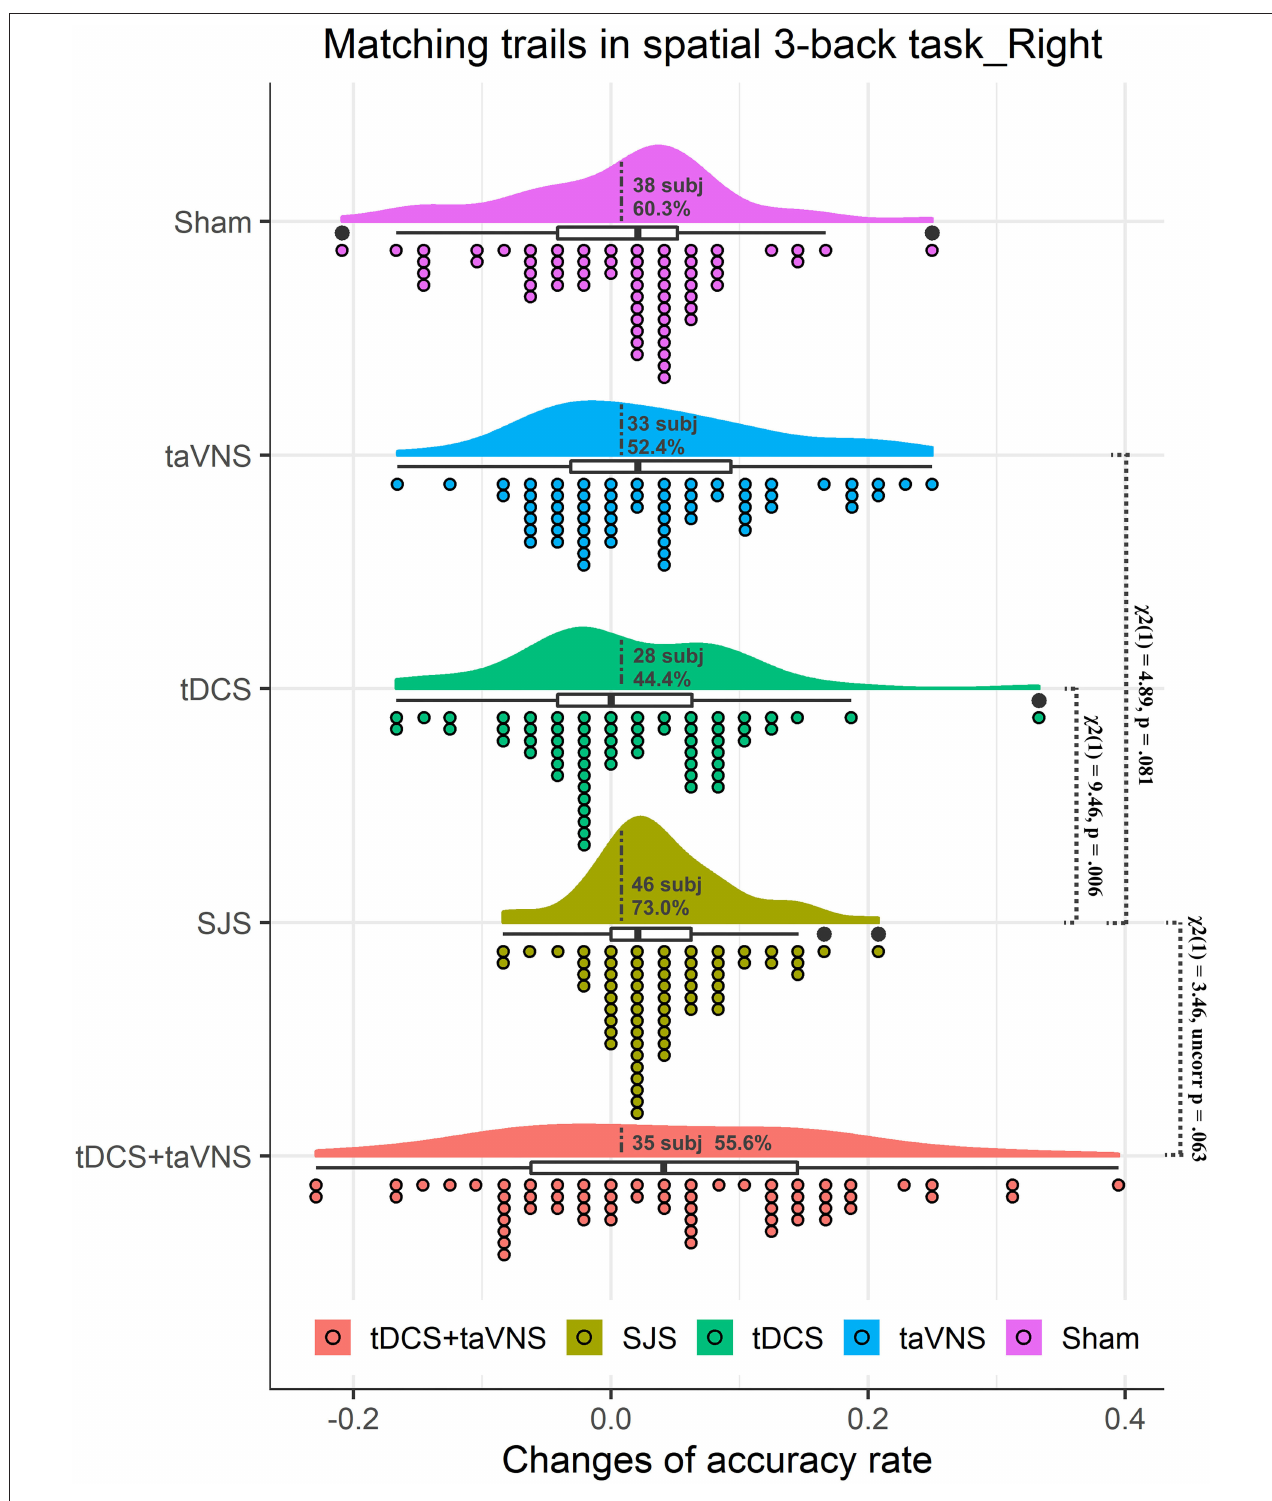
FIGURE 3 | Rain cloud plots of accuracy rate in matching trials (mACC) of the spatial 3-back task in experiment 2. Clouds and box plots represent the distribution of 1 -scores between the post-test and pre-test in taVNS, tDCS, SJS-R (simultaneous joint simulation of tDCS and taVNS), and tDCS + taVNS (the numerical summation effects of tDCS and taVNS) groups. Plots represent the 1 -score of each participant in the four conditions. Dotted lines separate positive change data with negative change data, and the number and proportion of subjects with improvements are presented in the clouds. The significant difference between tDCS and SJS-R groups and the improvement proportion difference between SJS-R and taVNS and tDCS + taVNS are presented in the figure.